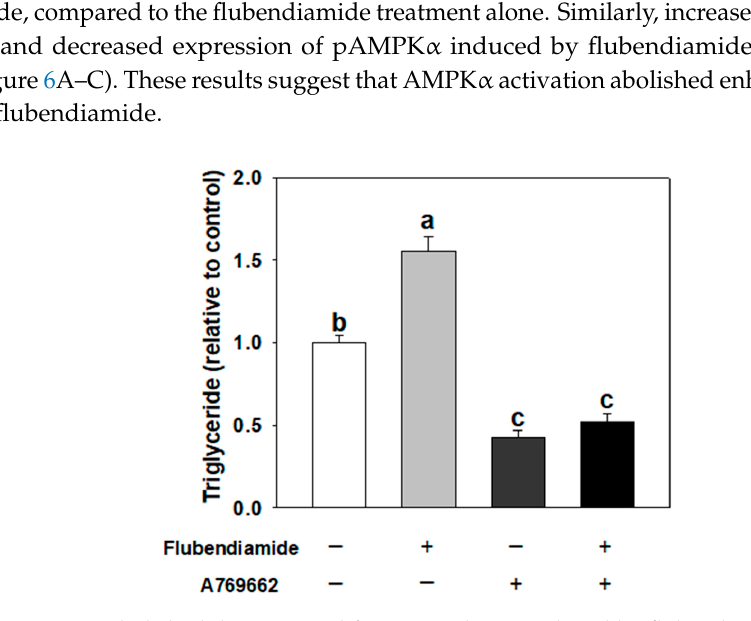
Figure 5. A769662 abolished the increased fat accumulation induced by flubendiamide. Cells were treated with flubendiamide (10 µ M) or A769662 (10 µ M) for 8 days. Each value is expressed as the mean ± standard error of three separate experiments. Means with different letters were significantly different at p < 0.05 (a vs. b, a vs. c or b vs. c are significantly different).